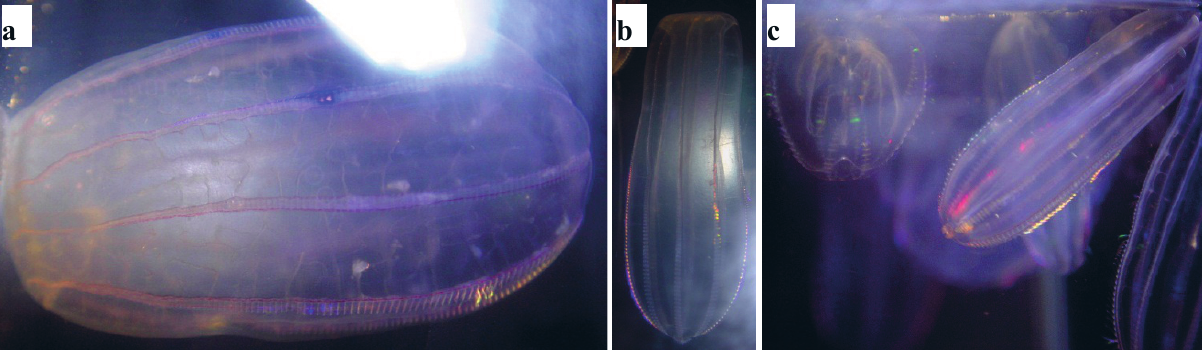
Figure 8. ( a ) Beroe cucumis ; ( b ) B. gracilis ; and ( c ) mixture of